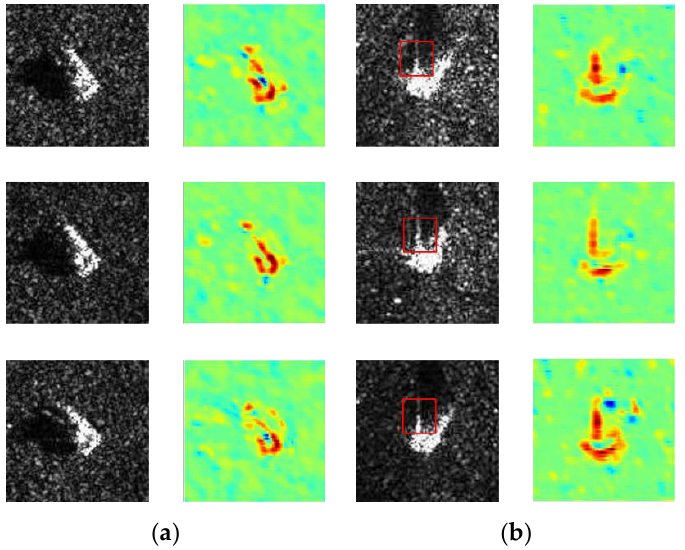
Figure 7. Heatmap comparison of similar images. ( a ) Heatmap comparison of similar images in Class 4. ( b ) Heatmap comparison of similar images in Class 9.